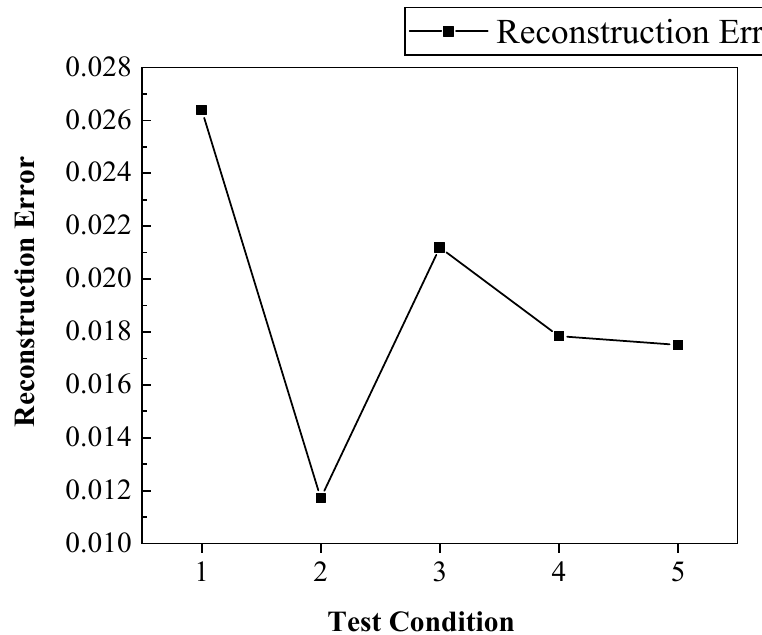
Figure 5. Reconstruction errors of bimodal temperature distribution model.